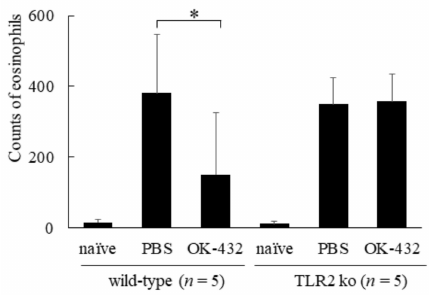
Figure 11. Eosinophil infiltration in nasal mucosae in a murine model of wild-type and TLR2 knock-out mice systemically sensitized with OVA and receiving subsequent intranasal challenge of OVA. Naive mice underwent no systemic sensitization. PBS-treated mice were i.p. injected with PBS on day 0 and day 7. OK-432-treated mice were i.p. injected with 100 mg OK-432 on day 0 and day 7. Data were obtained and expressed as the mean of triplicate determinations ± SD. Per experimental group, five mice were used. *, p <